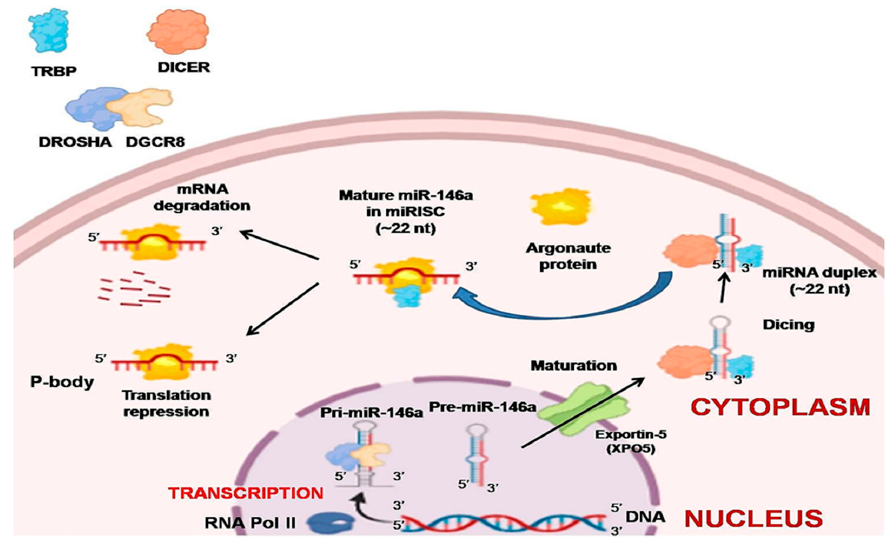
Figure 1. Biogenesis of miR-146a. Pri-miR-146a is formed by RNA polymerase II, which is further processed by capping, splicing, and polyadenylation. The long pre-miR-146a is cleaved by the microprocessor to release a hairpin-shaped pre-miR-146a. This leaves the nucleus through exportin 5 (XPO5) into the cytoplasm. In the cytoplasm, DICER with transactivation-responsive RNA-binding protein (TRBP) further acts on the pre-miR-146a to generate miRNA duplex. Argonaute protein selectively binds to one of the strands of miRNA, and a miRNA-induced silencing complex (miRISC) assembly is formed. The strand to which argonaute binds serves as a guide strand and leads the complex to complementary target mRNAs with GW182 protein family members for post-transcriptional gene silencing forming processing bodies (P-bodies). The other fate of miRNA is degradation if it is not